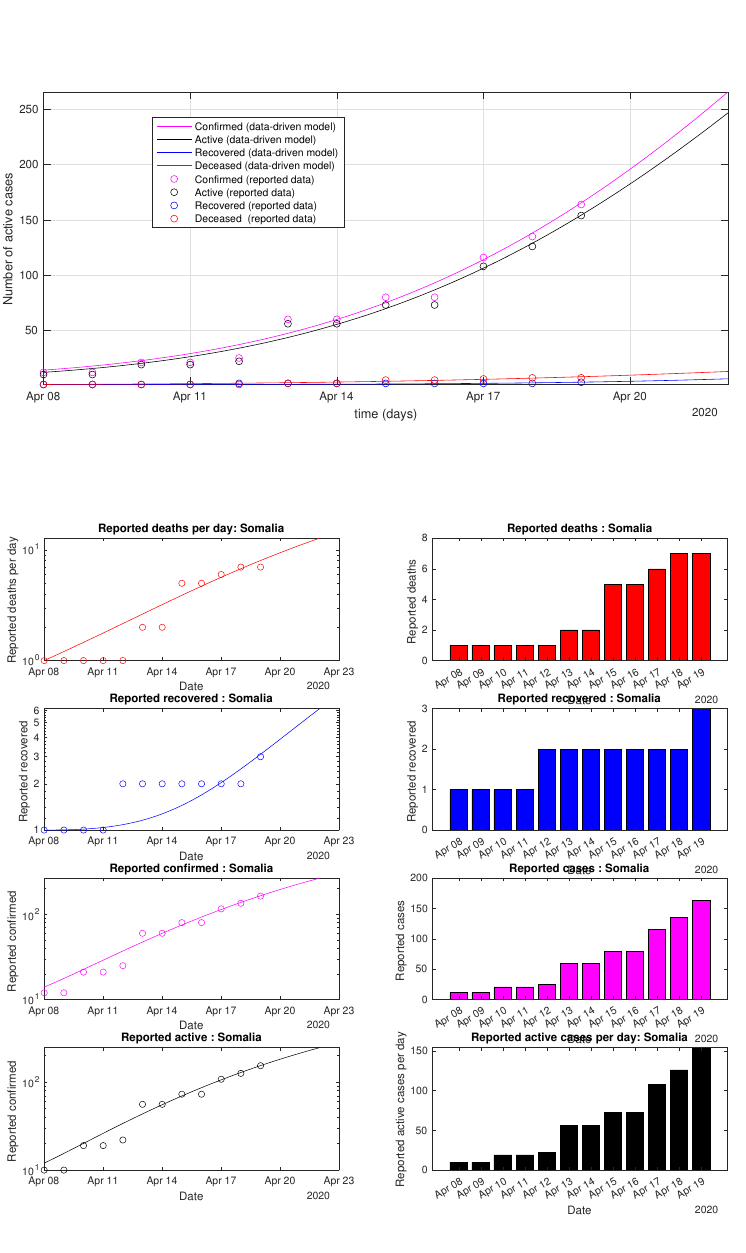
Figure 83. Somalia: data vs.